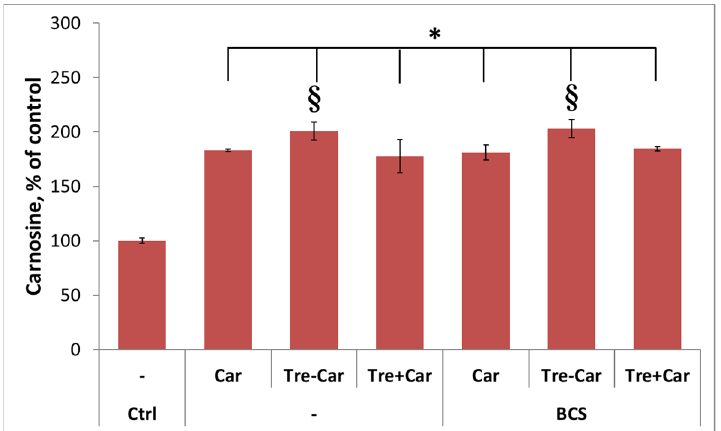
Figure 2. Transfer of Car, its derivative with Tre and in its mixture with Tre into the cells. In-cell Car concentration was determined with anti-carnosine antibody by indirect ELISA assay. Cells were incubated with 5 mM Car, Tre-Car or Tre + Car mixture with or without BCS for 24 h, and cell lysates were analyzed for Car level (* p ≤ 0.05 versus control untreated cells; § p ≤ 0.05 vs. Car treatment).